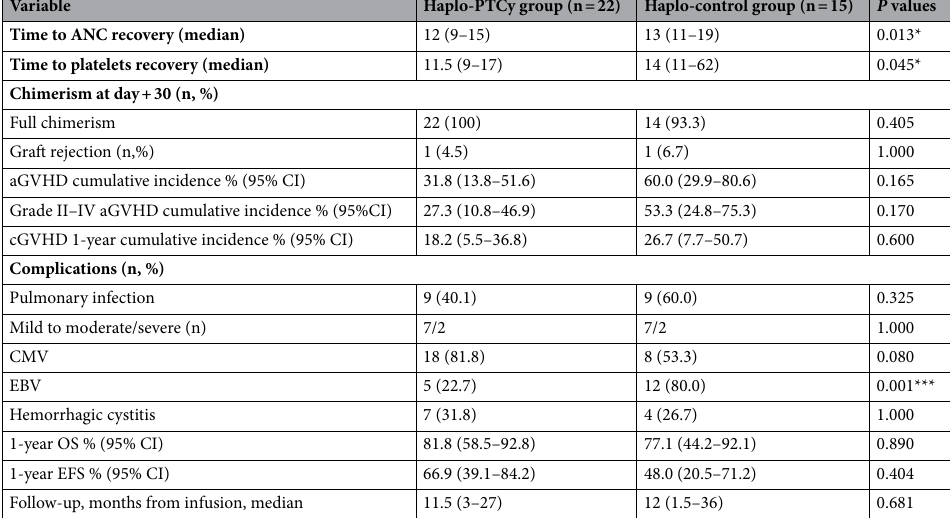
Table 4. Transplantation outcomes in haplo-HSCT groups. Continuous variables were expressed as median values and ranges; Discrete variables were expressed as counts (%). Cumulative incidences of aGVHD and cGVHD were estimated using competing risk model. P -value log-rank tests and Fisher exact test. * P < 0.05, *** P <